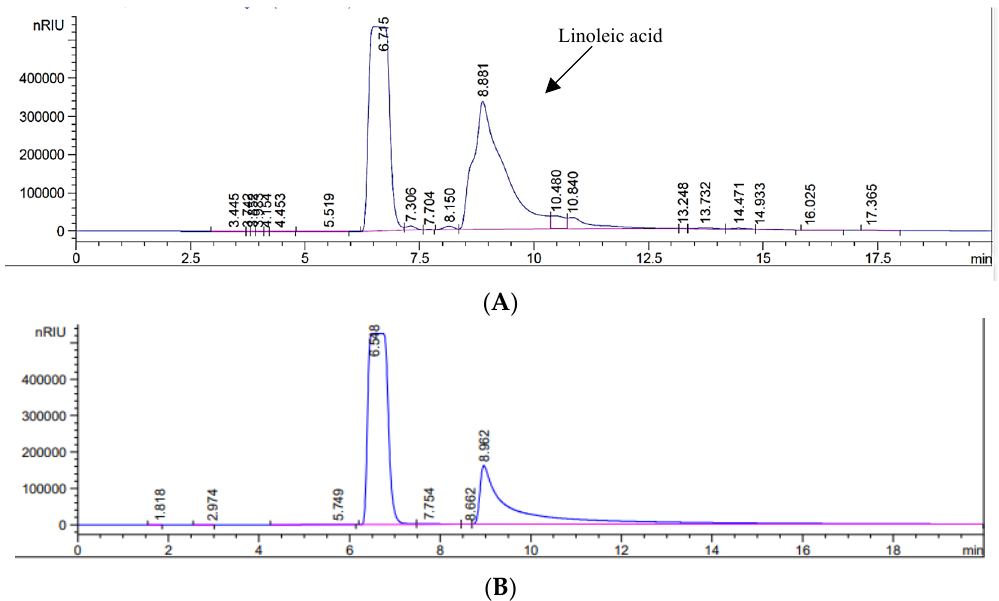
Figure 5. HPLC chromatograms of fraction C ( A ) and HPLC-grade LA standard ( B ).